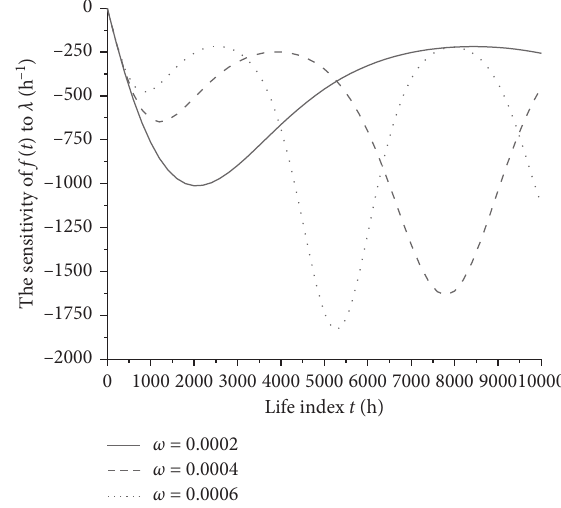
Figure 30: The sensitivity of f ( t ) to λ ( ω � 0.0002/0.0004/0.0006).